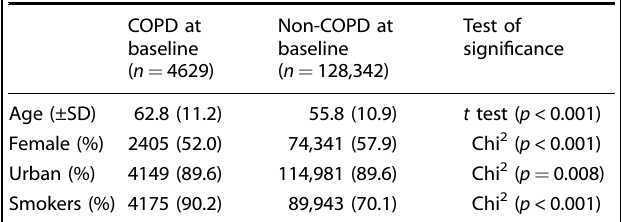
Table 1. Demographic